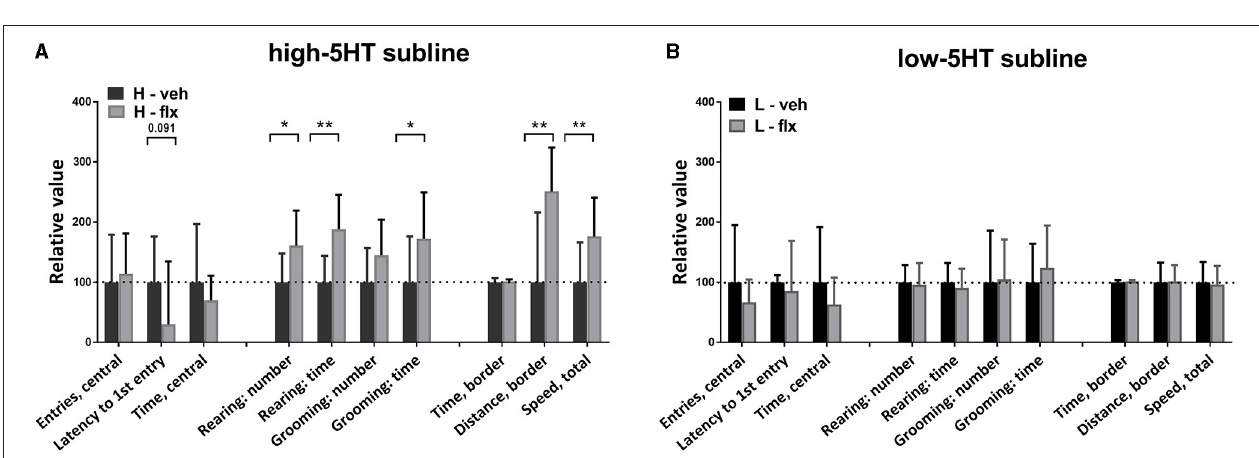
FIGURE 3 | Effects of fluoxetine on (A) platelet 5HT levels, and (B) platelet-free plasma 5HT levels in animals from high-5HT and low-5HT subline ( F 3,28 = 373 and 8.23, p < 0.0001 and p = 0.0002, respectively, 1w-ANOVA). Blood was collected from the jugular vein after 9 days of treatment. Data are shown as individual values with group means and SD, n = 8 per group. p -values obtained by post-hoc (Fisher’s LSD) test are given. H = high-5HT animals, L = low-5HT animals, veh = vehicle, flx = fluoxetine. * p < 0.05 and **** p < 0.0001.